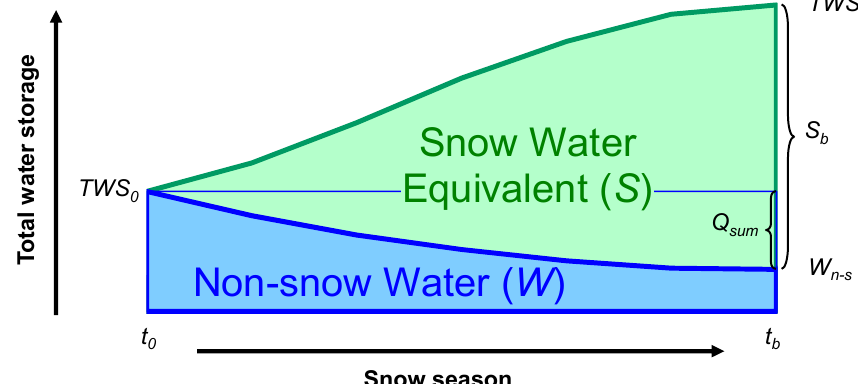
Figure 3. Diagram illustrating snow accumulation (S) and non-snow water (W) discharge for the Mackenzie River Basin in snow cover season. t 0 and t b : start and breakup time of the snow season; TWS 0 and TWS b : basin total water storage (S + W) at time t 0 and t b ; W n-s : non-snow water at time t b ; S b : Snow Water Equivalent at t b ; Q sum : accumulated basin water discharge in the snow season.